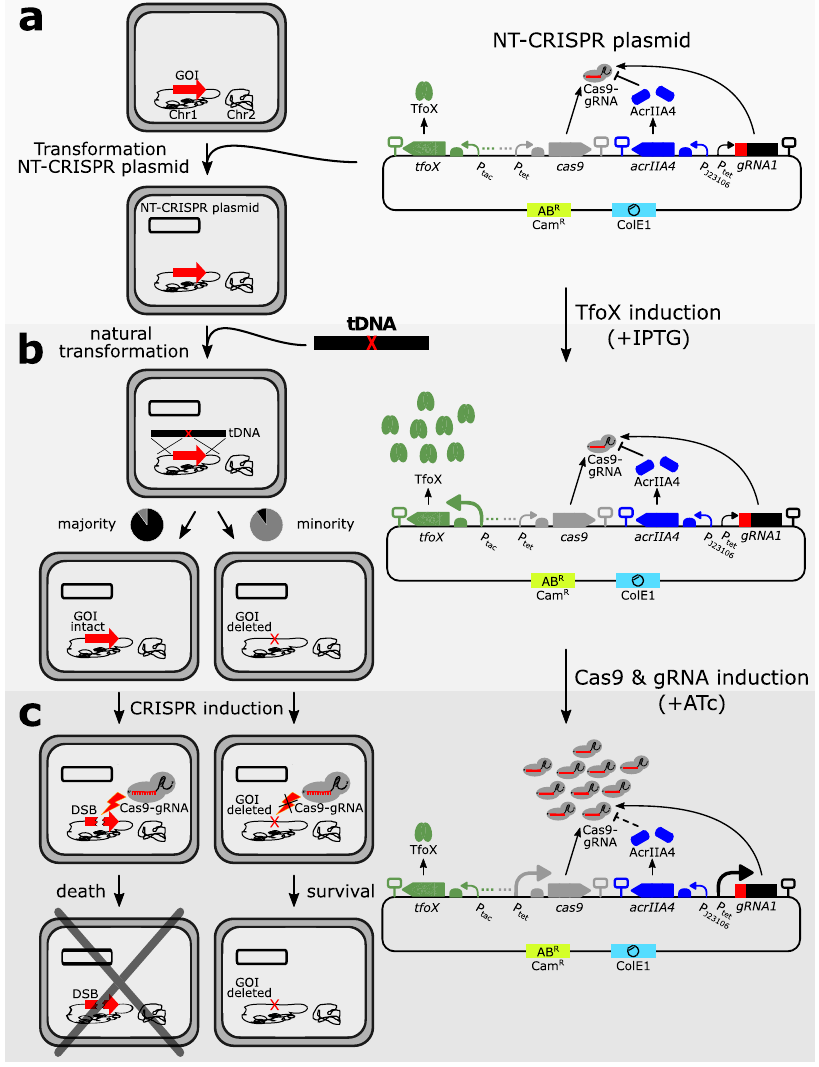
Fig. 1 Overview of the NT-CRISPR work fl ow. NT-CRISPR plasmid carries tfoX (P tac , green), cas9 (P tet , gray), acrIIA4 (J23106, blue) and gRNA, consisting of gRNA spacer (red) and scaffold (black), controlled by P tet . The backbone carries a chloramphenicol resistance marker (Cam R ) and a ColE1 origin of replication. Increasing abundance and size of promoter indicate increased expression. SBOL symbols for omitted detail (three points) represent the transcriptional unit for the regulatory proteins LacI and TetR for P tac and P tet , respectively. a V. natriegens cells are tranformed with the NT-CRISPR plasmid. The gene of interest (GOI) is indicated with a red arrow on chromosome 1 (black). b Expression of tfoX is induced by IPTG and tDNA is introduced. The tDNA is homologous to the sequences fl anking the GOI. The majority of cells are not modi fi ed and the GOI stays intact, while a minority looses the GOI (red X). c Production of Cas9 and gRNA is induced by ATc. A DSB is introduced in wild type cells (discontinued red arrow) by Cas9-gRNA, leading to cell death. No DSB is introduced in genome edited cells, permitting